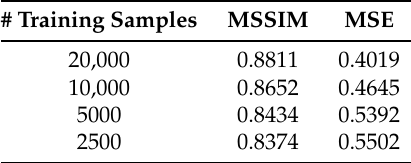
Table 3. Quantitative indexes of the proposed method in the case of different numbers of training